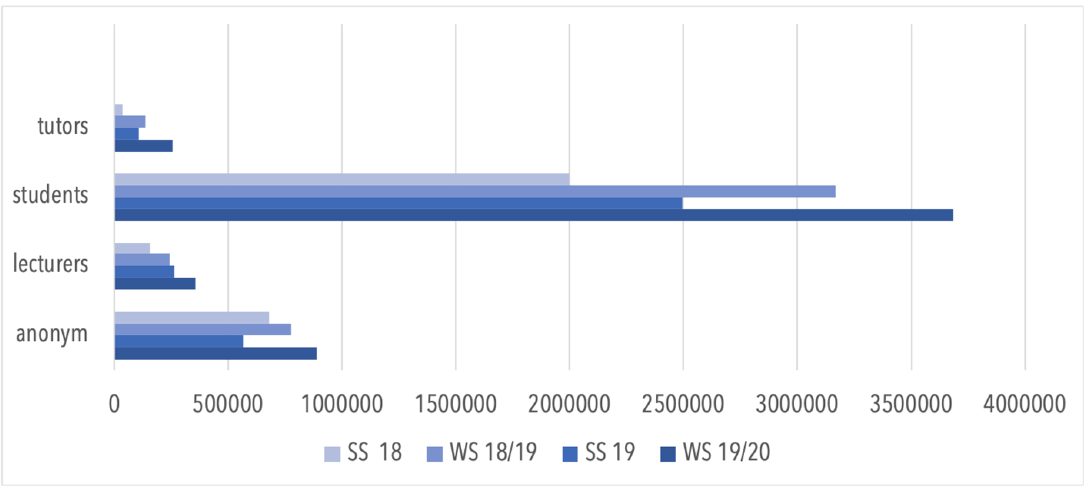
Figure 2. Sum of activities in TeachCenter for different user groups per semester at Graz University of Technology. Source: Graz University of Technology, Educational Technology. Note: SS is an abbreviation for summer semester, WS for winter semester.